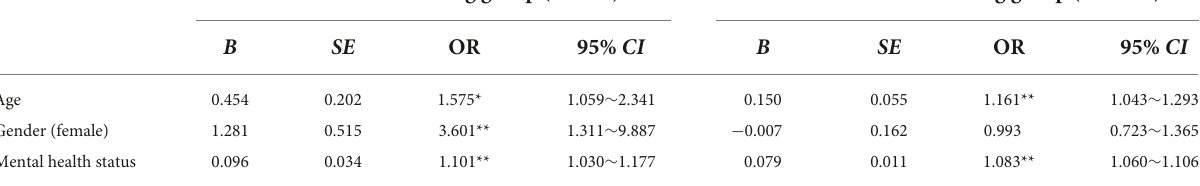
TABLE 2 Multiple logistic regression of predictors at baseline for the trajectories of VT.